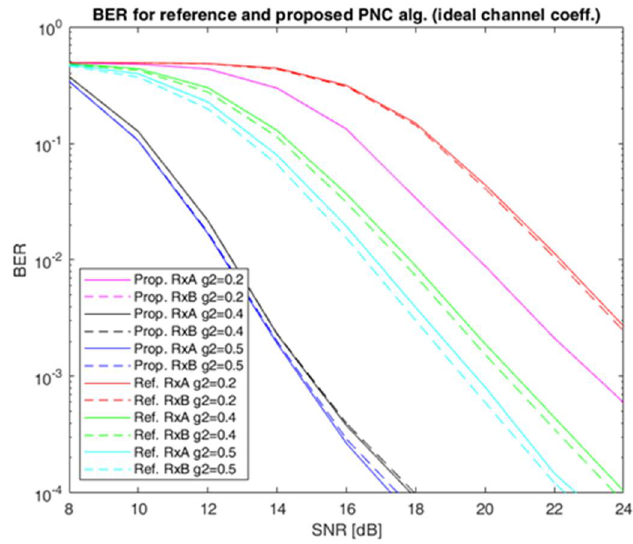
Figure 7. BER on the output of the receiver of terminal A (RxA) and terminal B (RxB) for several g after two-way data values of the weighting coefficient 2